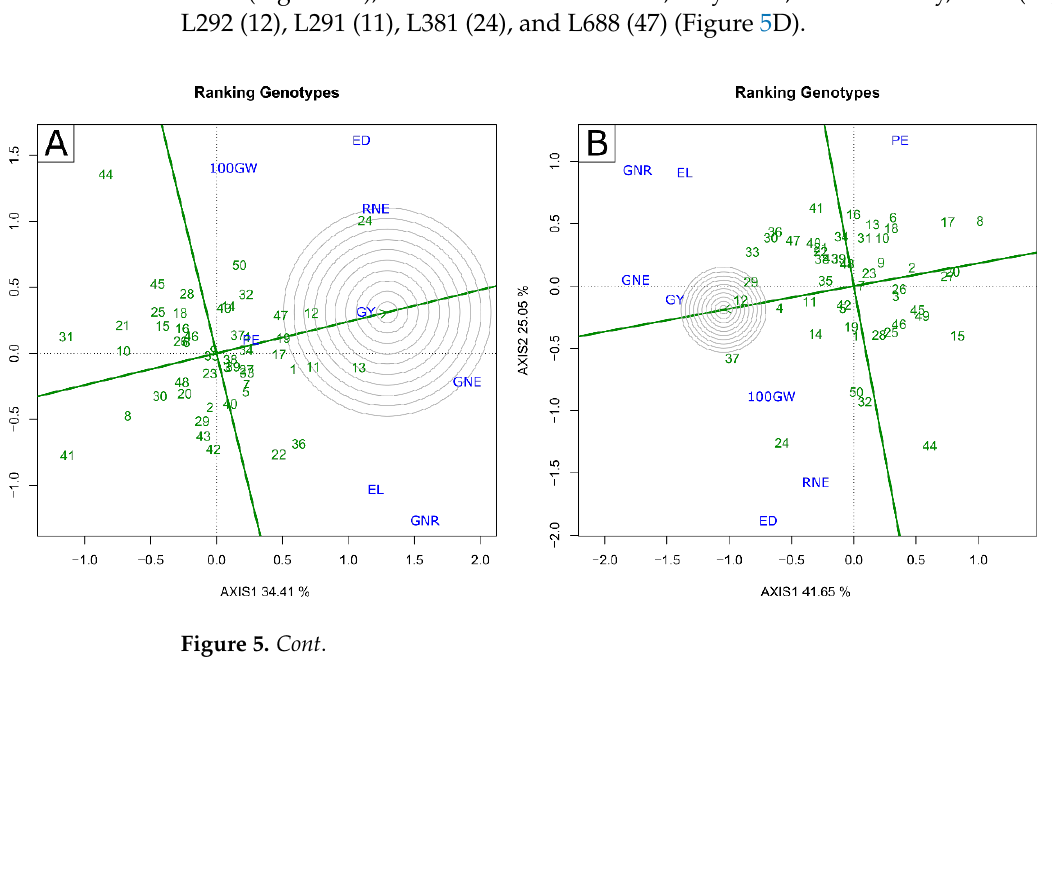
Figure 5. Biplot “Ranking Genotypes” graph for ( A – C ) water stressed (WS) and ( B – D ) well-watered (WW) conditions, in crop seasons 2020 ( A , B ) and 2021 ( C , D ). GY — grain yield; PE — Popping expan- sion; GNE — grain number per ear; 100 GW — 100-grain weight; RNE — Row number per ear; GNR — Grain number per row; ED — Ear diameter; EL — Ear length; (-) signal indicating negative values. 3. Discussion 3.1. Genetic Variability in Different WC and CS Genetic variability was observed between the lines for most of the evaluated traits, also noting the efficiency of the water suspension in the period of male pre-anthesis to differentiate WC. Withholding irrigation from 10 to 15 days before male flowering is widely adopted by corn breeders worldwide [10,12,17,27 – 30]. The use of this procedure makes it possible to reliably affirm the adaptive response of plants to the drought condi- tion, which can be measured, above all, through the productive potential [28,29]. Due to the significant effect of CS and WC and the significant interactions with gen- otype (G), a differential response of the evaluated popcorn lines is expected. In the plant selection process, interactions of this nature interfere in the recommendation of cultivars for specific environments, as well as for selection gains (Hallauer et al., 2010). Regarding the presence of significance for the interactions G*CS, G*WC, and G*CS*WC, it can be inferred that, for these traits, selection under irrigated conditions or with water deficit may be effective in obtaining simultaneous genetic gains in both CS and WC. For this reason, the experiments were analyzed individually; thus, the genotype effect (G) was effectively measured in both crop seasons and water conditions.